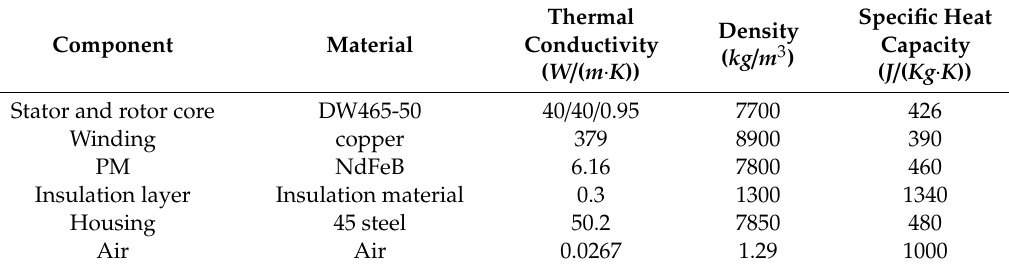
Table 3. Material properties of